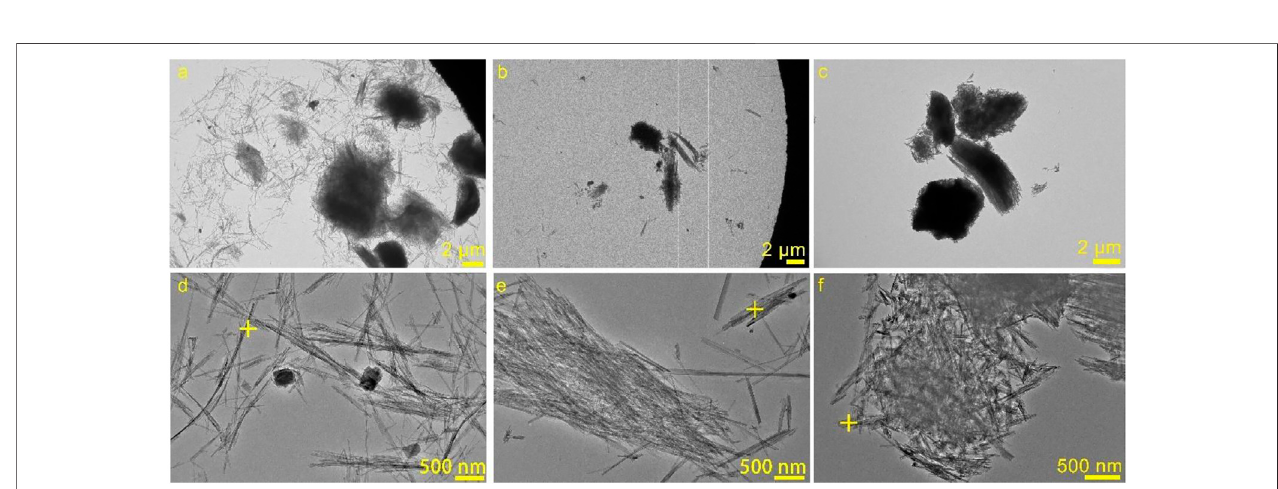
FIGURE 2 | (A) XRD patterns of Sep, Al-3.50-Sep, and Al-70.0-Sep. (B) Partially enlarged view of Figure 2A .